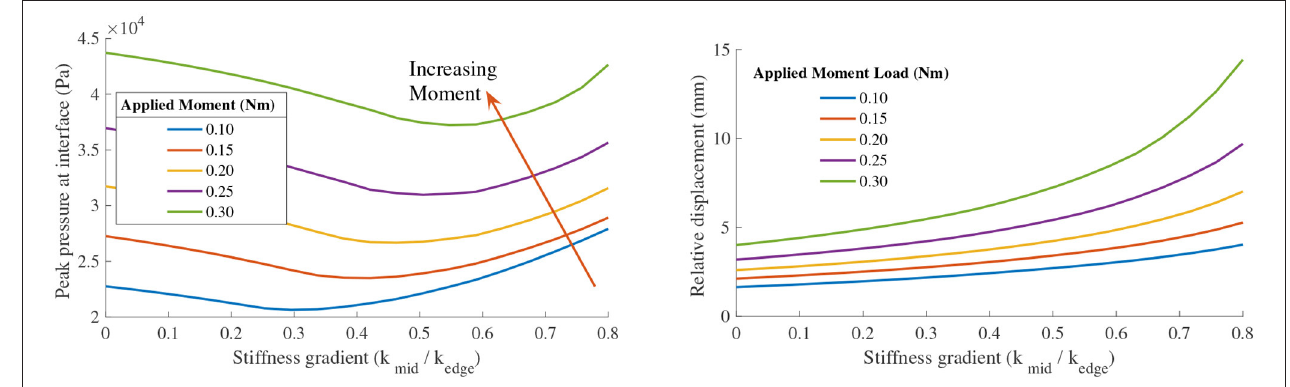
FIGURE 15 | (Left) Plot of peak pressure at the PHRII interface (as a measure of user comfort) vs the stiffness profile gradient for different applied moment loads at constant bias force. (Right) Plot of the effect on relative displacement between the human skeleton and the attachment base on changing the stiffness profile gradient of the